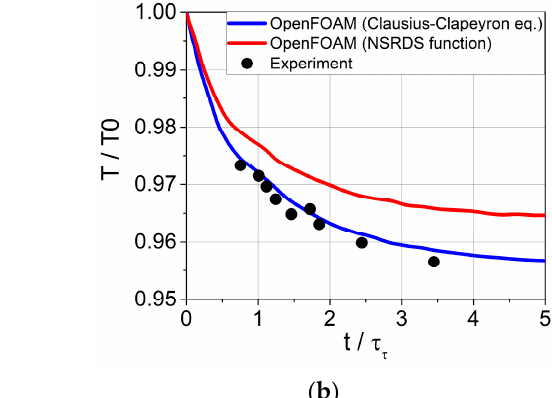
Figure 3. Problem statement: droplet trajectory in the flow.